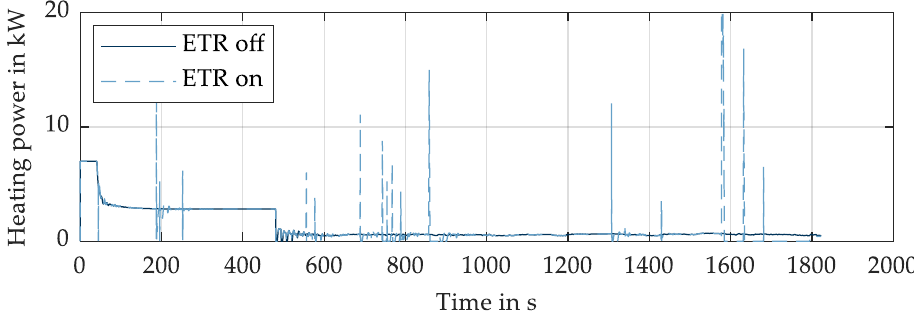
Figure 8. Power consumption of the coolant heater in one FTM cycle at 10 °C.